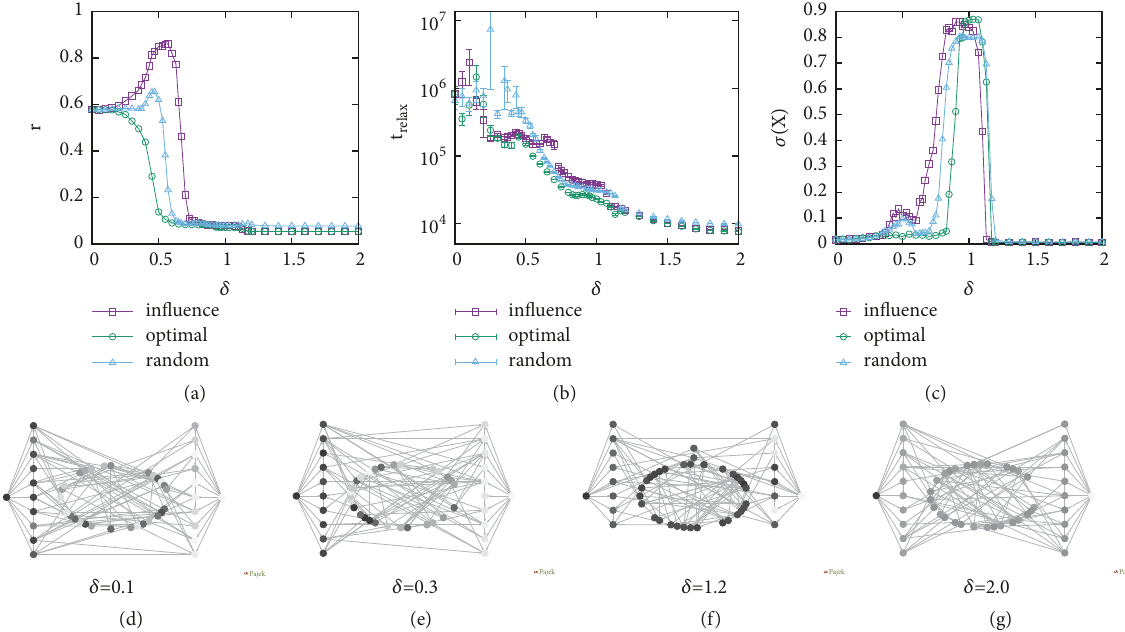
Figure 8: Dependence of outcomes of the adaptive influence dynamics on 훿 for a scenario of two external controllers with opinions ±1 attempting to maximize their influence on the system: (a) opinion dispersion, (b) relaxation times, and (c) standard deviation 휎(푋) of the average opinion X. The figures compare three different settings for rewiring: competitive influence maximization (influence), rewiring to reduce 푟 (optimal), and random rewiring (random). Results are averaged over 50 independent runs for a system of 푁 = 998 nodes noise Δ = 0.001 , ⟨푘⟩ = 9 . The external controllers have out-degrees 푘 = 509 , so that the overall network has average degree ⟨푘⟩ = 10 and we use ext 푚 = 1 . The bottom row shows example network configurations for a network composed of 50 nodes with ⟨푘⟩ = 4 and external influencers controlling 10 nodes each. External controllers are indicated as black or white agents at the boundaries of each network visualization. Nodes directly controlled by the two external controllers are aligned along vertical lines next to the controllers, whereas nodes that are not directly controlled are positioned along an ellipse in the centreof each network visualization. The figures are for settings of 훿 = 0.1 or 훿 = 0.3 (firstand 2nd from left, two opinion clusters), 훿 = 1.2 (middle, one opinion has won), and 훿 = 2.0 (right, consensus has been reached as a